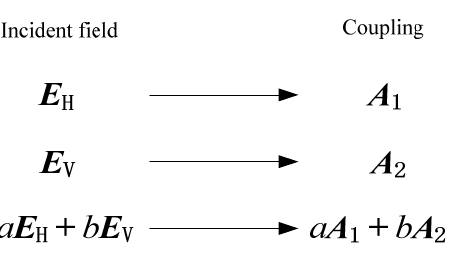
ters (electric field, magnetic field, voltage, or current) of the subject is shown in Figure 1. Where E H and E V denote the horizontal and vertical polarized illuminated EM wave with the same amplitude (or peak value) and waveform, respectively; A 1 and A 2 denote the coupling parameters corresponding to E H and E V, respectively, A 1 , A 2 , E H, and E V are all vectors; a and b are parameters that can take any values.